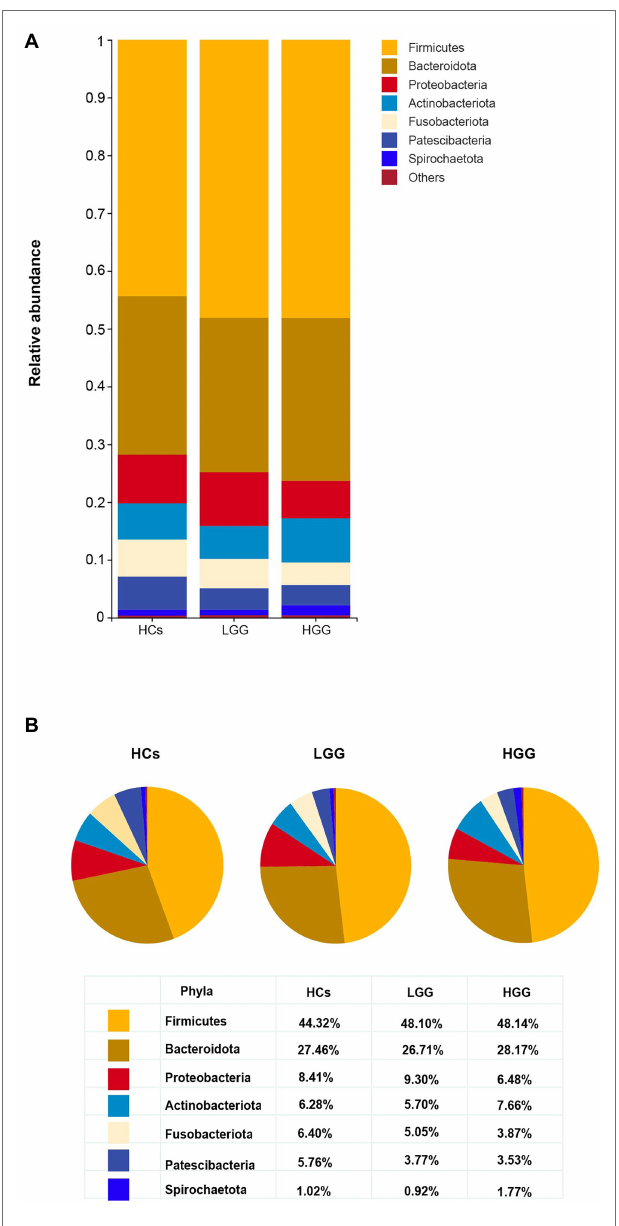
FIGURE 2 | Comparison of the structures of the oral microbiome at the phylum level among HCs, LGG, and HGG. (A) The seven most abundant bacteria phylum in the oral microbiome, “Others” represents the bacteria with the relative abundance of less than 1%; (B) the proportion of Firmicutes, Bacteroidetes, Proteobacteria, Fusobacteria, Actinobacteria, Patescibacteria, and Spirochaetota in each group at the phylum